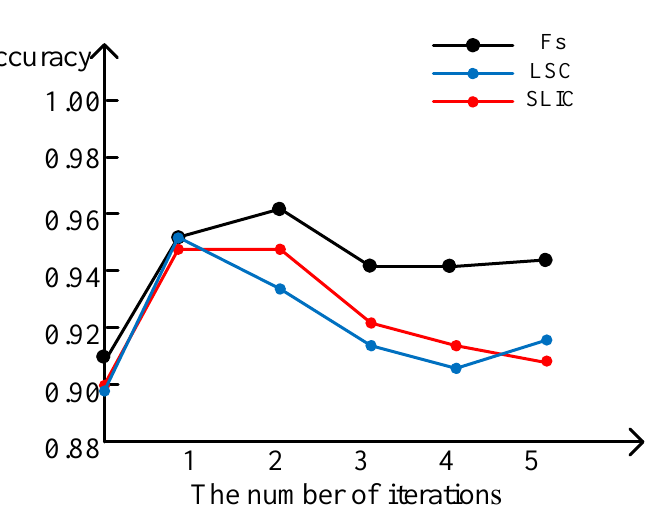
Figure 14. Performance of three superpixel algorithms.